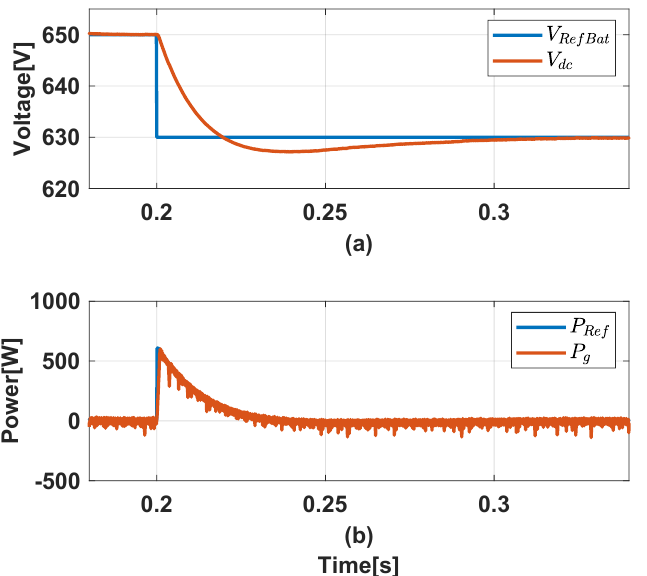
Figure 17. Dynamic response for power active step: ( a ) current and voltage α component response; ( b ) active and reactive powe responses.